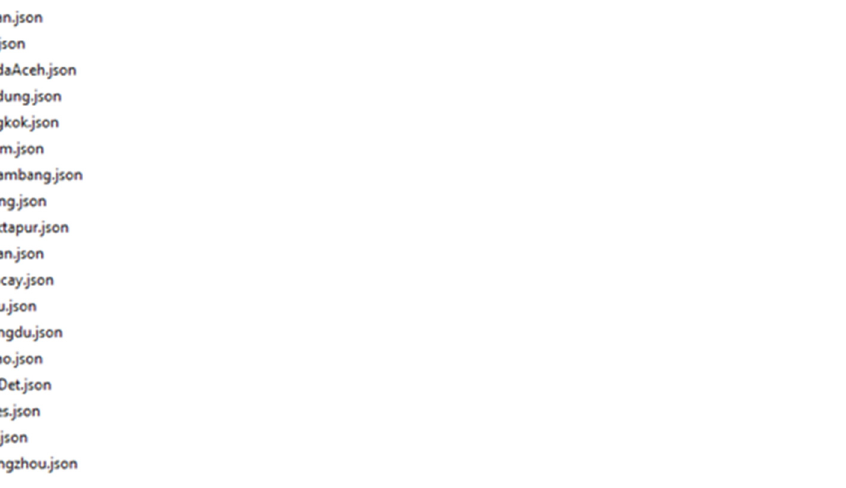
Figure 8. List of JSON files using Python programs to extract reviews from web portals.